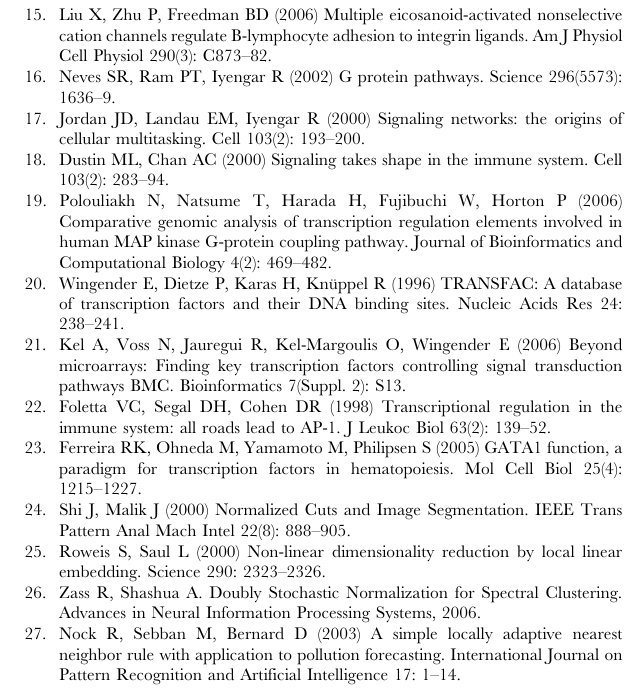
Figure S1 NO/NO (without cAMP or Ca2 + response) ligands clustered. Except for fMLP-NGF and PAF-IFNb pairs of ligands all ligands this group look uncorrelated, without the explicit projection to the particular downstream clusters. Found at: doi:10.1371/journal.pone.0004189.s003 (5.97 MB TIF) Figure S2 NO/NO ligands clustered together with AIG NO/ YES (strongest Ca2 + -inducing ligand). AIG is the closest to CD40, LPS, CpG and IL4 ligands with strong proliferate and differen- tiation response [5]. It is interesting to notice that adding AIG ligand made the picture of NO/NO ligands completely reorga- nized, thus brining those 5 ligands closely, while all others moved away. Found at: doi:10.1371/journal.pone.0004189.s004 (5.97 MB TIF) Figure S3 The common and specific transcription factor binding sites (TFBS) found in 4 sub-groups of YES/NO and YES/YES ligands groups of B-Cell. Horizontal axis lists the matrices names, which former parts (like ‘MZF1’ in MZF1_01) indicate the TFBS name and the latter parts (like ‘_01’ in MZF1_01) point to the experimental-base quality of the matrices in the descending order from ‘1’ to ‘6’. From the top 30 TFBS we selected matrices within the quality index range from 1 to 4. Asterisks* indicate known regulators of the Immune System, which constitutes 23% of the total number of TFBS (25/78) for B-Cell. The respective number of genes in the right-down corner indicates the numbers of genes which promoters were subjected to the transcriptional analysis and depicted in Figure 3 of the manuscript.